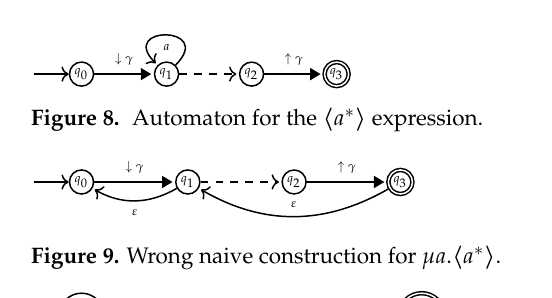
Figure 9. Wrong naive construction for µ a .